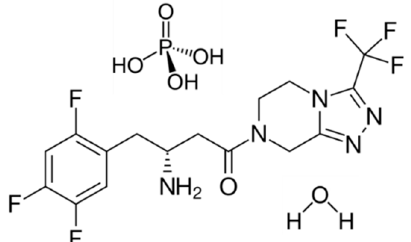
Figure 1. Chemical structure of sitagliptin phosphate monohydrate.